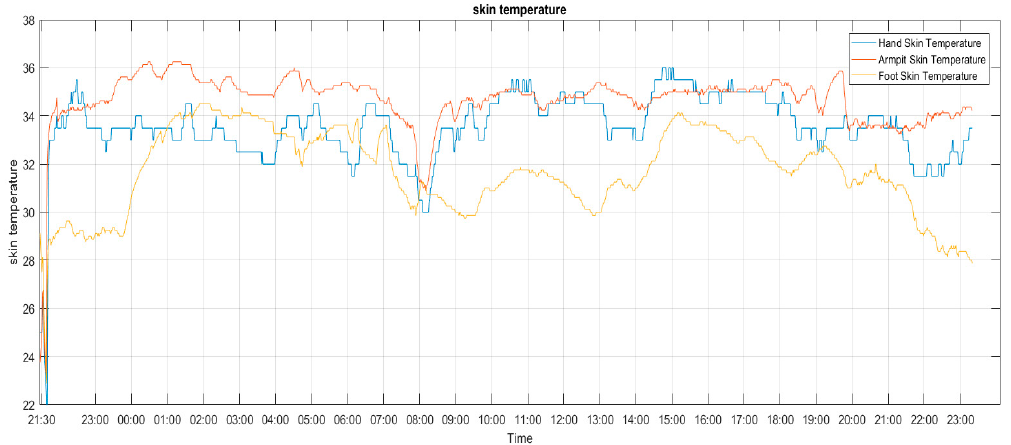
Figure 4. Wrist, distal, and proximal skin temperature measurements via iButtons .